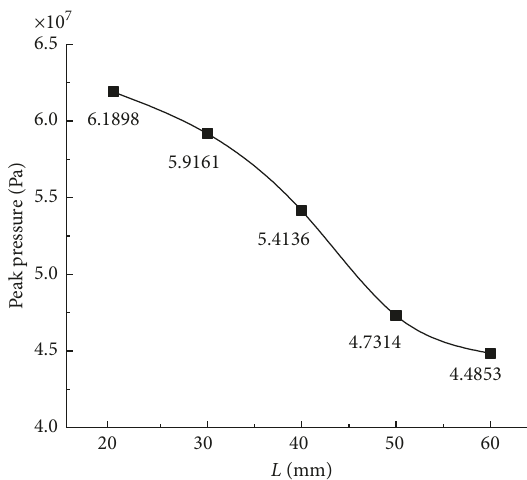
Figure 13: Relationship between peak pressure and L .